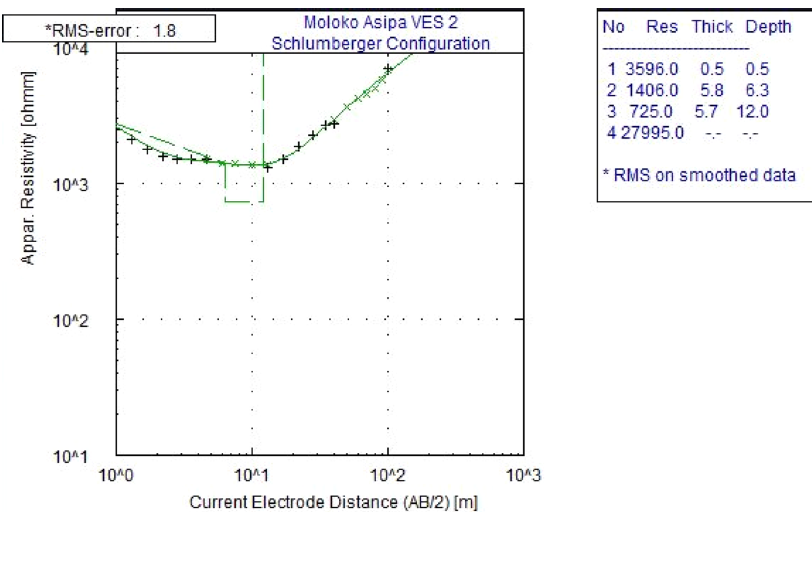
Fig. 12 Layer model interpreta- tion for VES 2